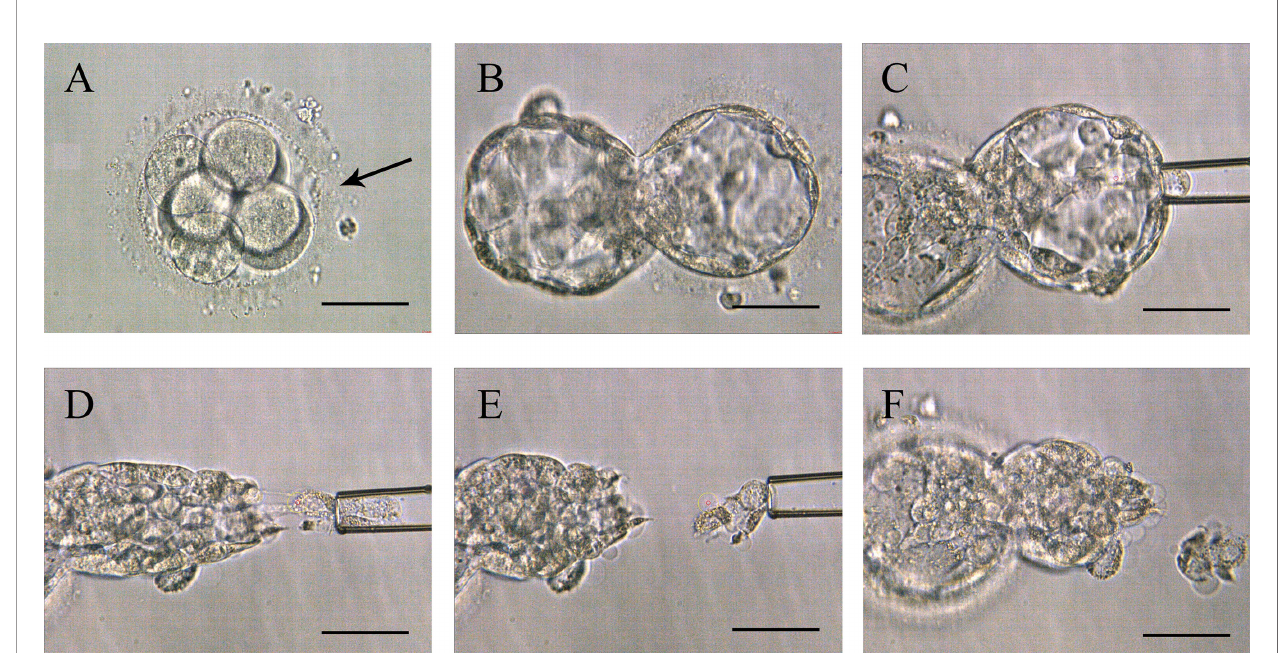
FIGURE 1 | Procedures of Strategy A. (A) The zona pellucida was opened a 10-15 µm hole (pointed by the black arrow in the picture) by lasers to assist hatching on day 3. (B) Expanding blastocyst with trophectoderm cells herniating from the arti fi cial opening on day 5 or 6. (C) The biopsy pipette sucked the herniating cells. (D) Disconnected the junction in front of the biopsy pipette with lasers. (E) Trophectoderm cell samples isolated from the embryo ’ s body. (F) Blastocyst morphology after biopsy. Scale bar = 50